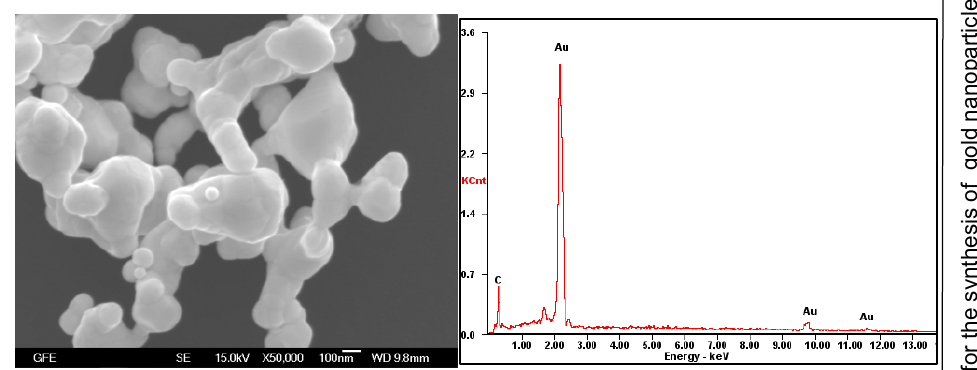
Figure 2 – SEM and EDS analysis of the gold particles obtained in the ultrasound field at room